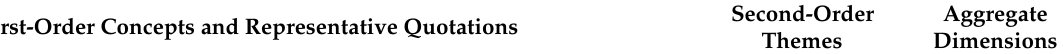
Table 6. Data Structure in the Expansion Stage